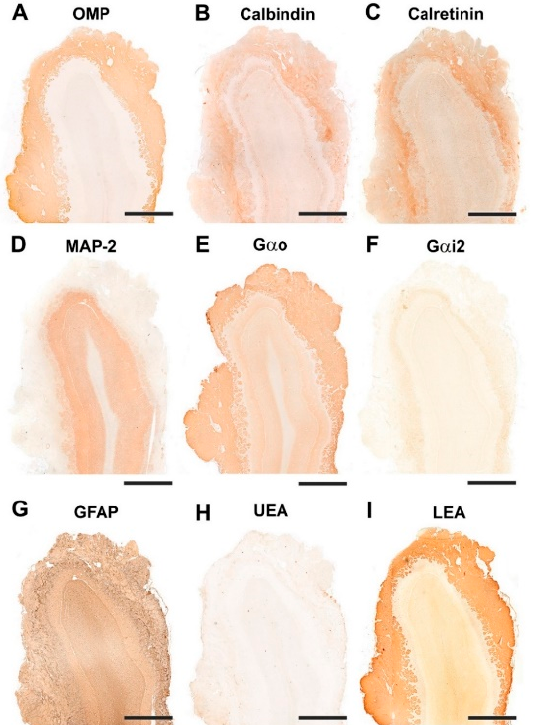
Figure 14. Immunohistochemical and lectin-histochemical study of the OB of the wolf. ( A ) Anti-Olfactory marker protein (OMP); ( B ) Anti-Calbindin; ( C ) Anti-Calretinin; ( D ) Anti-MAP-2; ( E ) Anti-Gao; ( F ) Anti-Gai2; ( G ) Anti-GFAP; ( H ) UEA histochemical labeling; ( I ) LEA histochemical labeling. Scale bars: 2 mm.